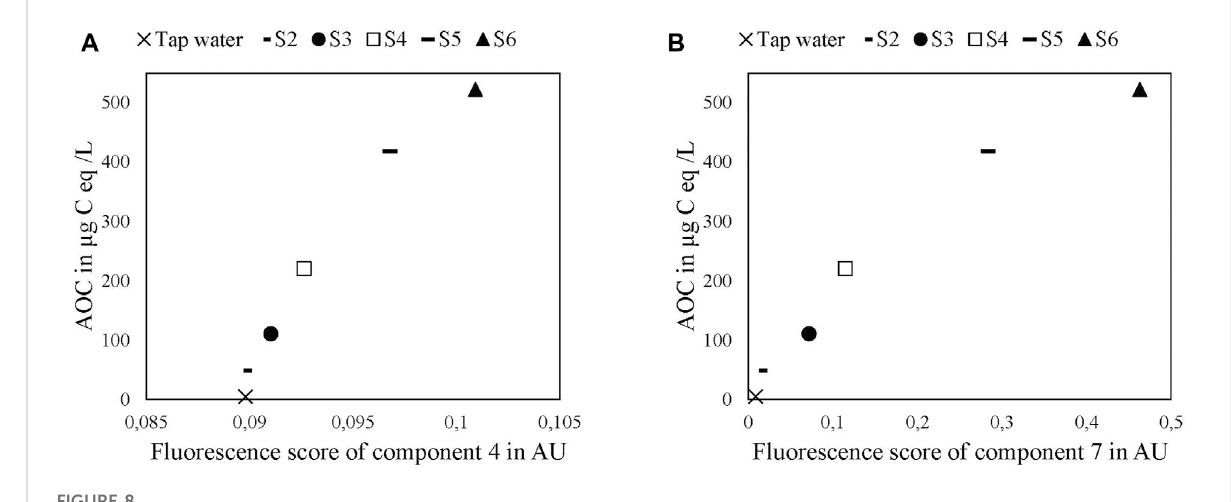
FIGURE 8 Correlations between fl uorescence scores in arbitrary units for Components 7 (A) and 4 (B) and AOC level in the tap water